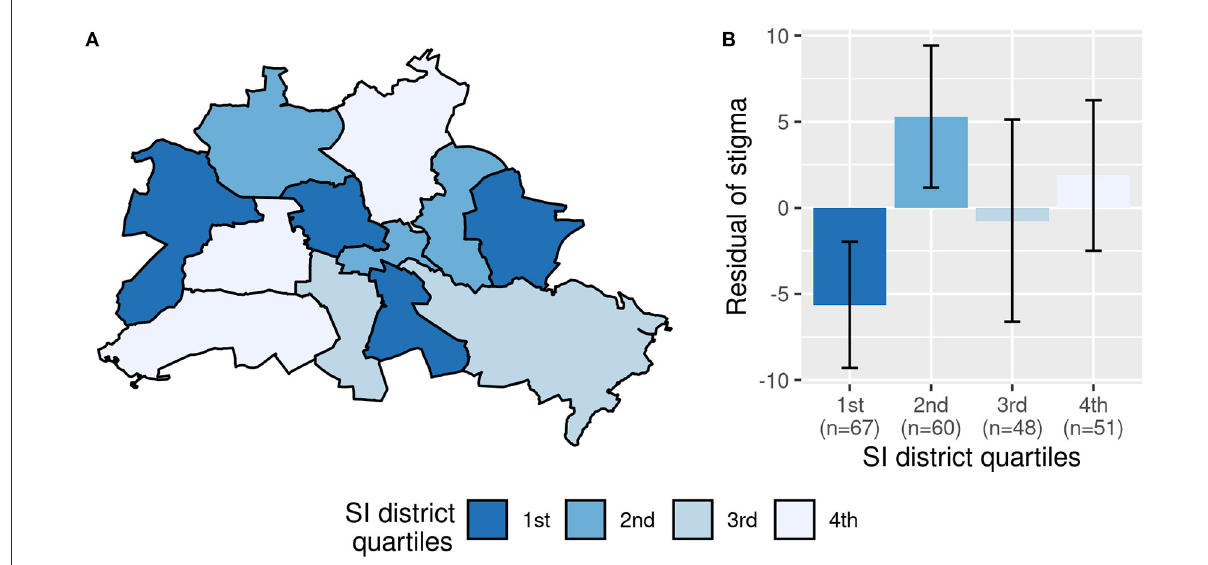
FIGURE1 Association between perceived stigma and social index of the district (“SI district”). (A) shows Berlin with its 12 districts. (B) Displays the mean residual stigma values of the quartiles of SI district with error bars representing 95% confidence intervals around the mean. The residuals are corrected for social index of the neighborhood, restrictions of daily life, unfavorable income and seizures in the past 6